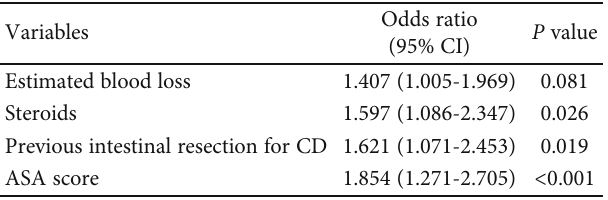
Table 5: Multivariate analysis of risk factors for postoperative